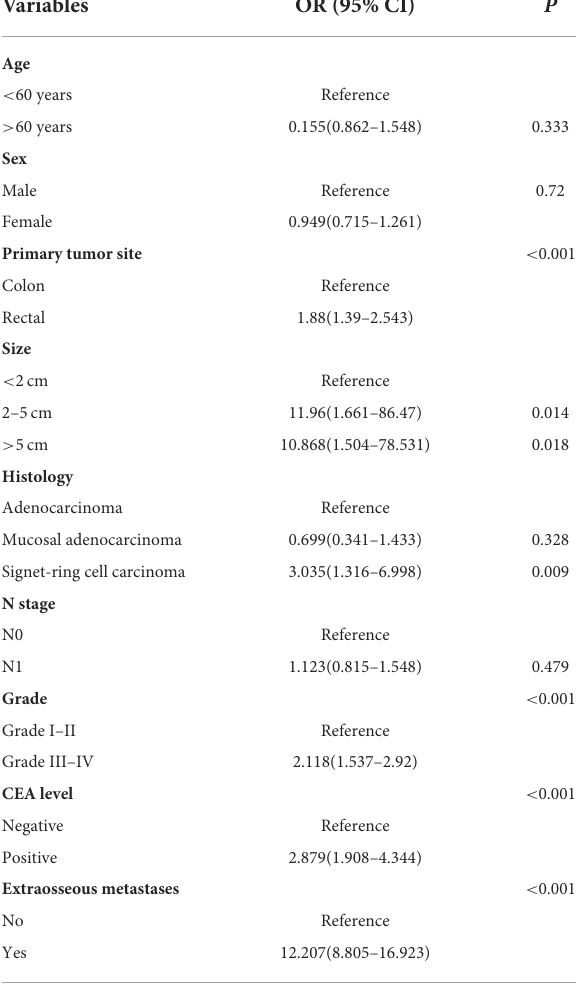
TABLE 2 Multivariable logistic regression model with enter variable